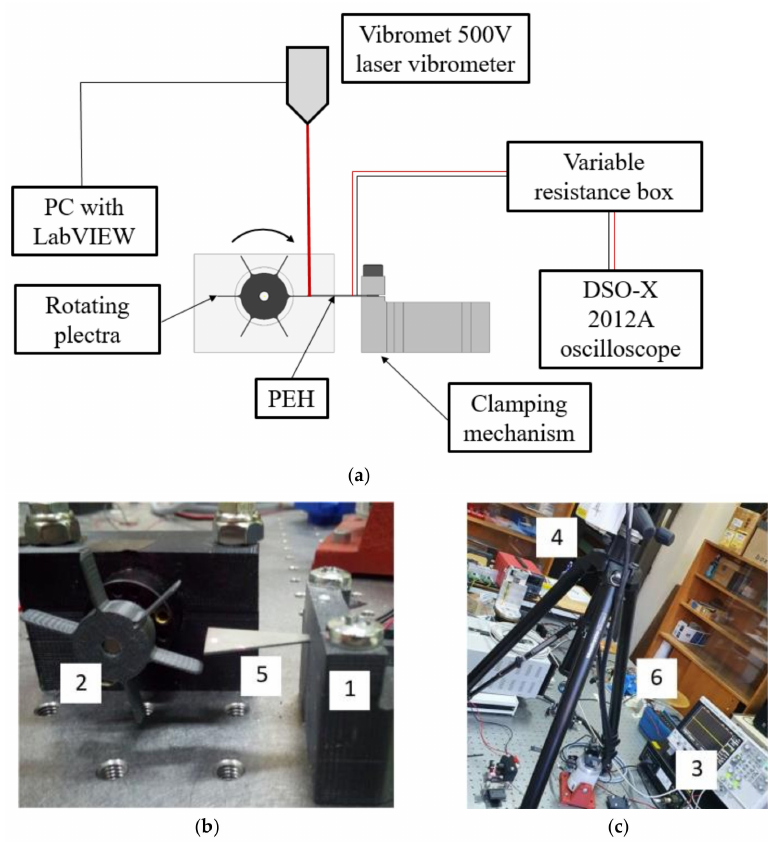
Figure 7. Schema of the FUC experimental setup ( a ) with the actual execution showing the plucking mechanism [38] ( b ) and the DAQ system [38] ( c